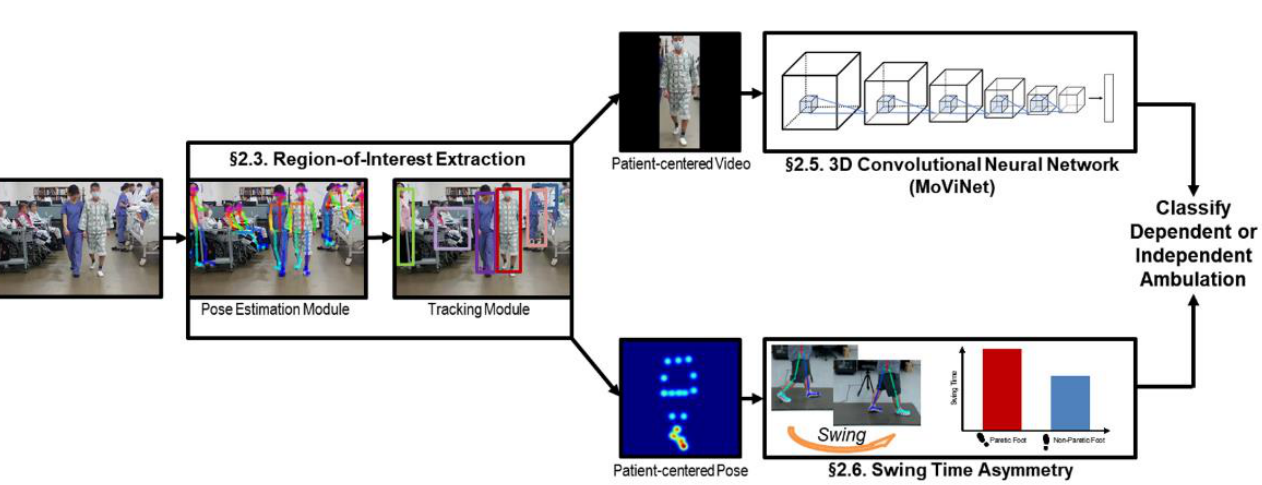
Figure 1. The design overview diagram for classification of dependence in ambulation in stroke patients.